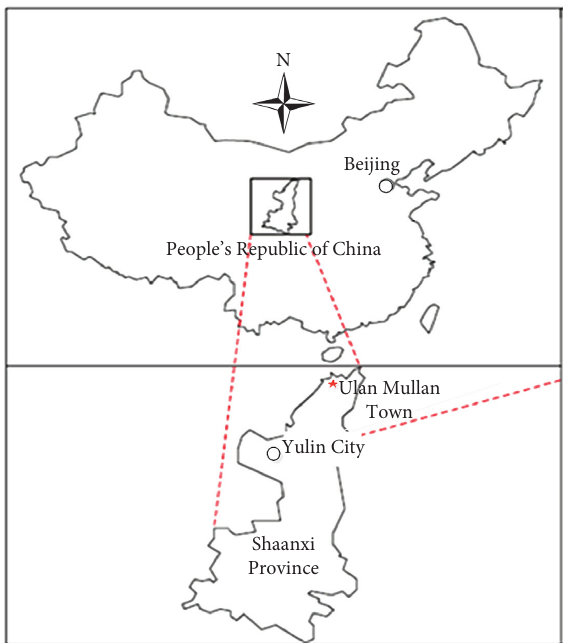
Figure 1: Geographical location of Daliuta Coal